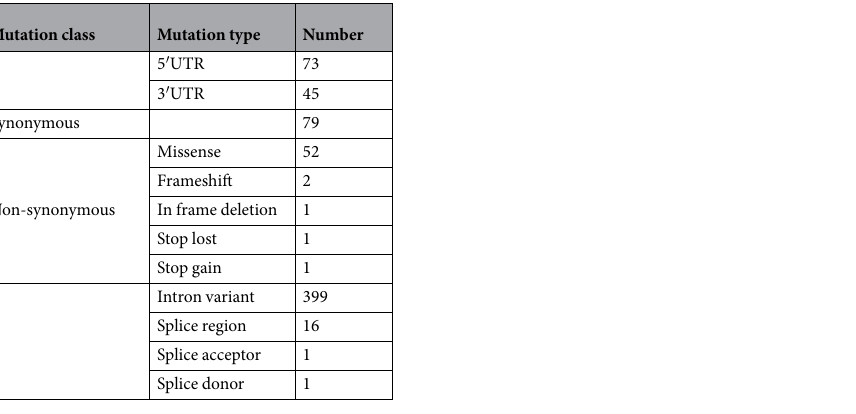
Table 1. Number and type of sequence changes identified within gene